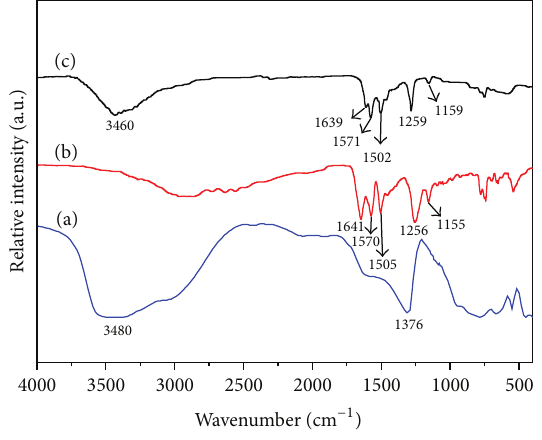
Figure 3: FTIR spectra of (a) Zn/Al-CO 32− -LDH, (b) HNOB, and (c) Zn/Al-HNOB − -LDH.